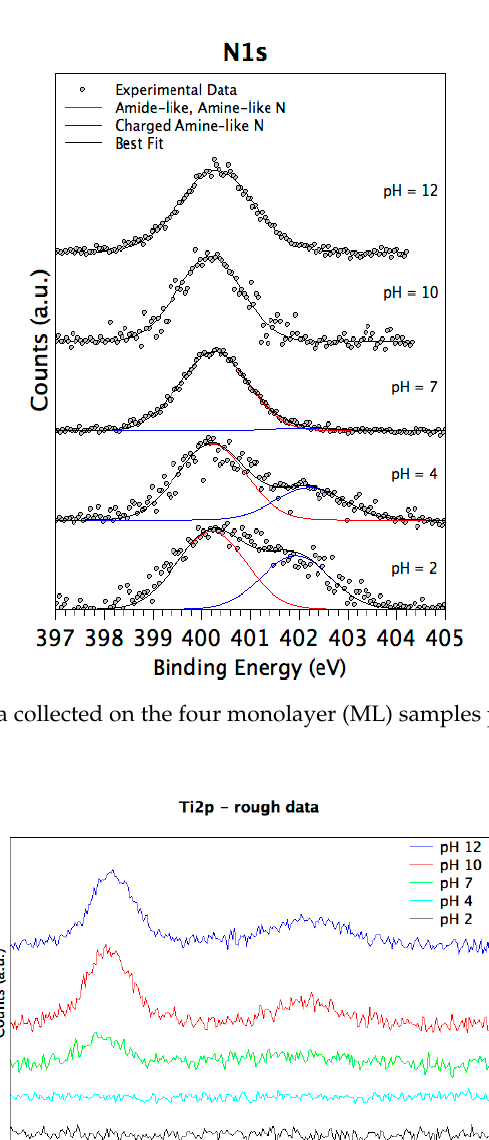
Figure 7. Rough Ti2p spectra, showing the attenuation of substrate signal with decreasing pH, indicative for a better peptide adsorption. indicative for a better peptide